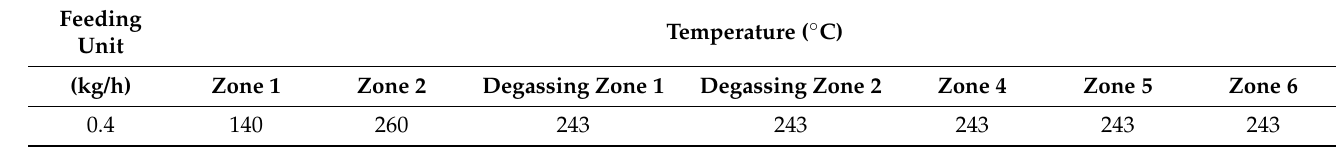
Table 2. Machine data for PET degassing and